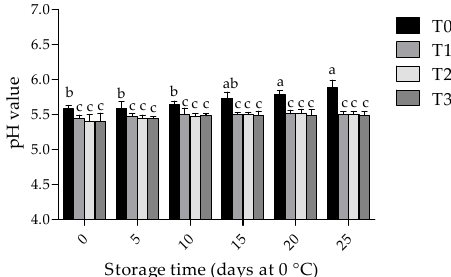
Figure 1. Effect of chitosan with GTWE and storage time on pH values of meat samples. Values expressed as mean ± standard deviation. T0 (non-coated chops and without GTWE); T1 (chitosan-coated chops without GTWE); T2 (chitosan-coated chops plus 0.1% of GTWE); and T3 (chitosan- coated chops plus 0.5% of GTWE). Different superscripts (a–d) indicate significant differences among treatment x storage time values ( p < 0.05).